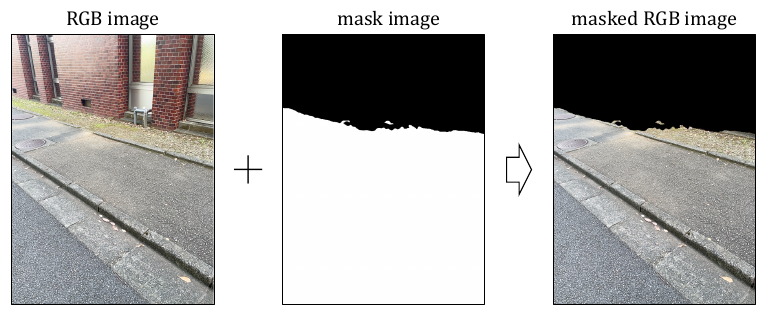
Figure 5. An example of a mask image and a masked RGB